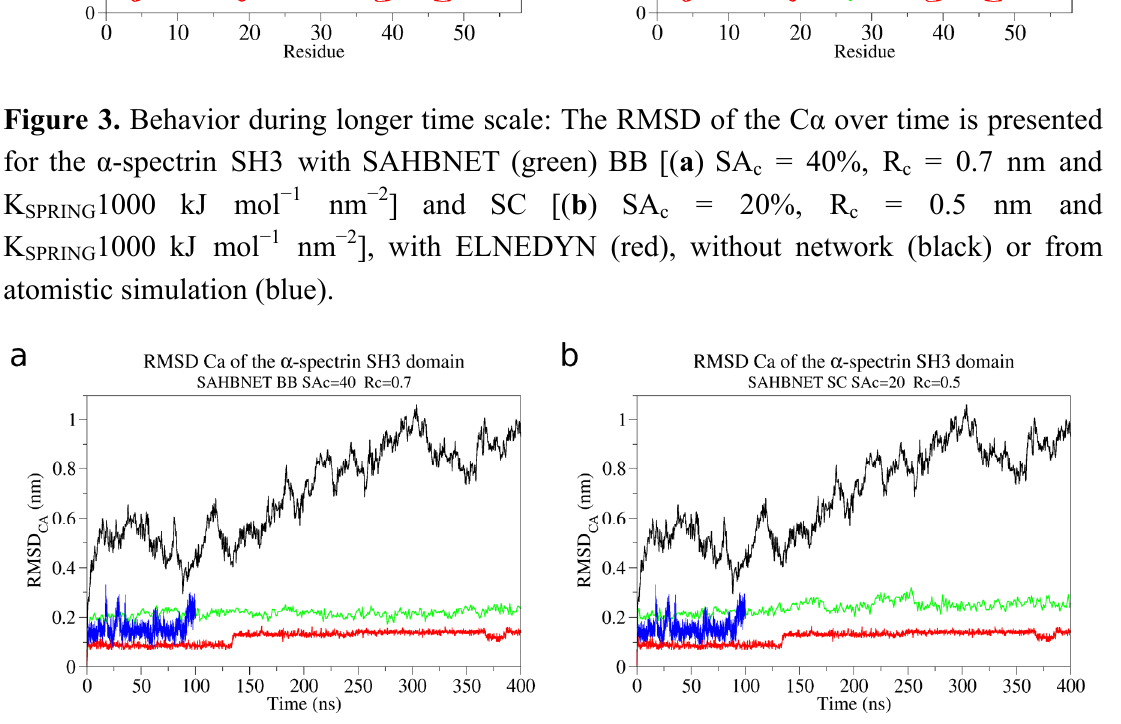
= 40%, R = 0.7 nm and c c = 20%, R = 0.5 nm and c c